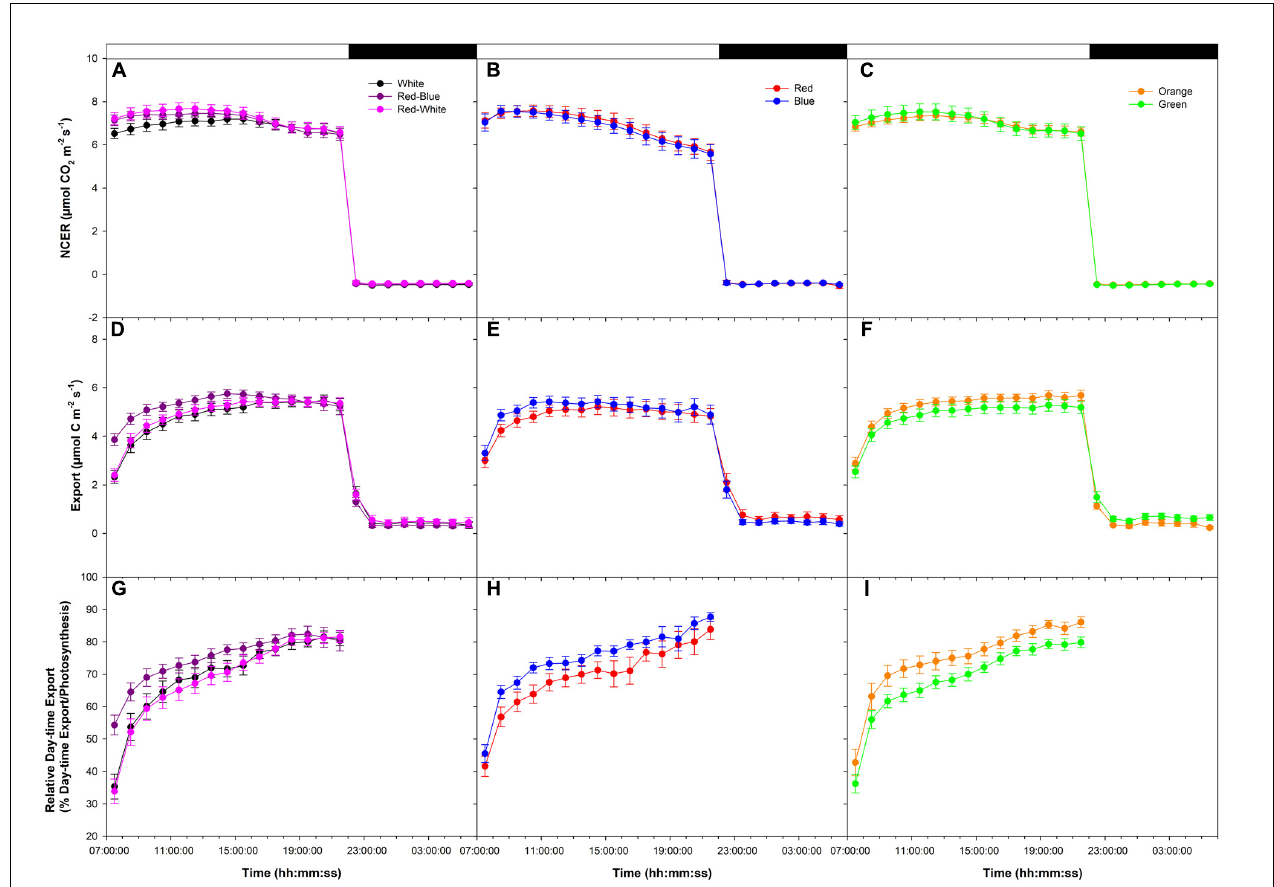
FIGURE 2 | Daily patterns of leaf NCER and export at an initial medium photosynthetic rate of ∼ 8 µ mol m − 2 s − 1 as affected by different spectral qualities. The NCER (A–C) , export (D–F) , and relative export (export as a percentage of photosynthesis; G–I ) exposed to mixed LEDs system, RB, W, and RW are shown in A,D,G . The NCER, export, and relative export from R and B are shown in B,E,H while O and G are shown in C,F,I